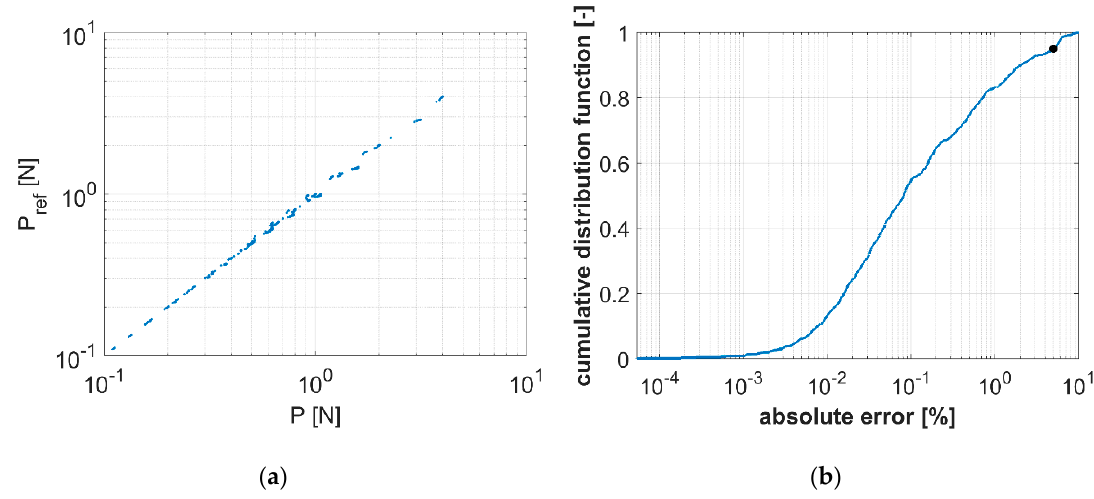
Figure 6. Solution error for P from the modified analytical approach, and P ref , the reference values derived from the FEM: ( a ) logarithmic regression plot of raw data and ( b ) cumulative distribution function plot of the data.